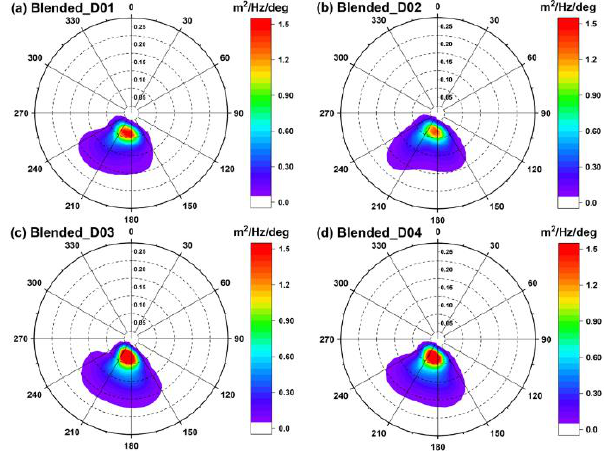
Figure 21. Comparison of the directional wave spectra at the Hualien wave buoy at 00:00 on 17